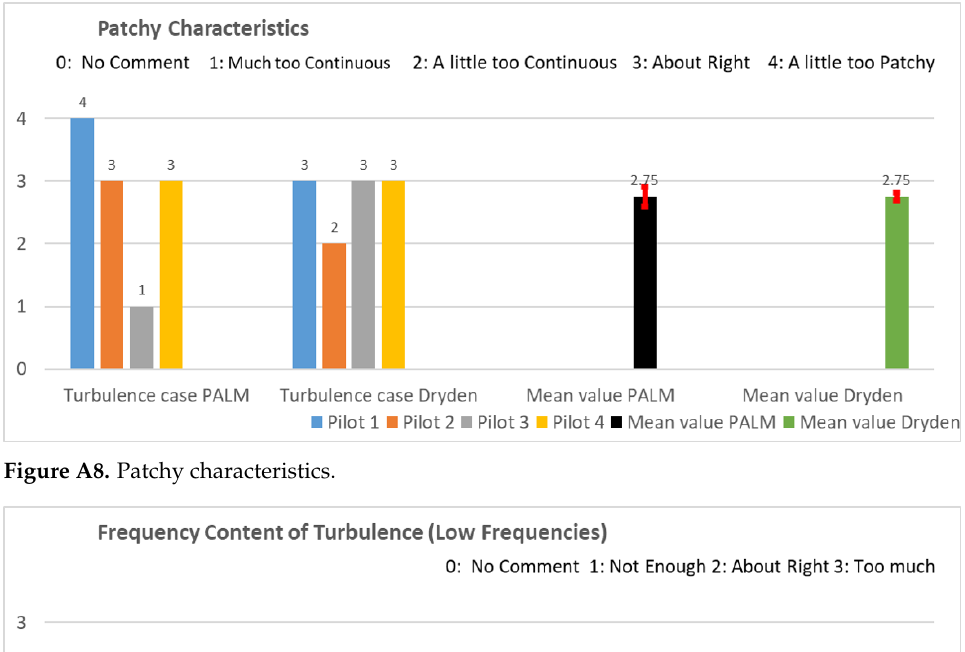
Figure A7. Correctness of relative amplitudes of disturbances (yaw).